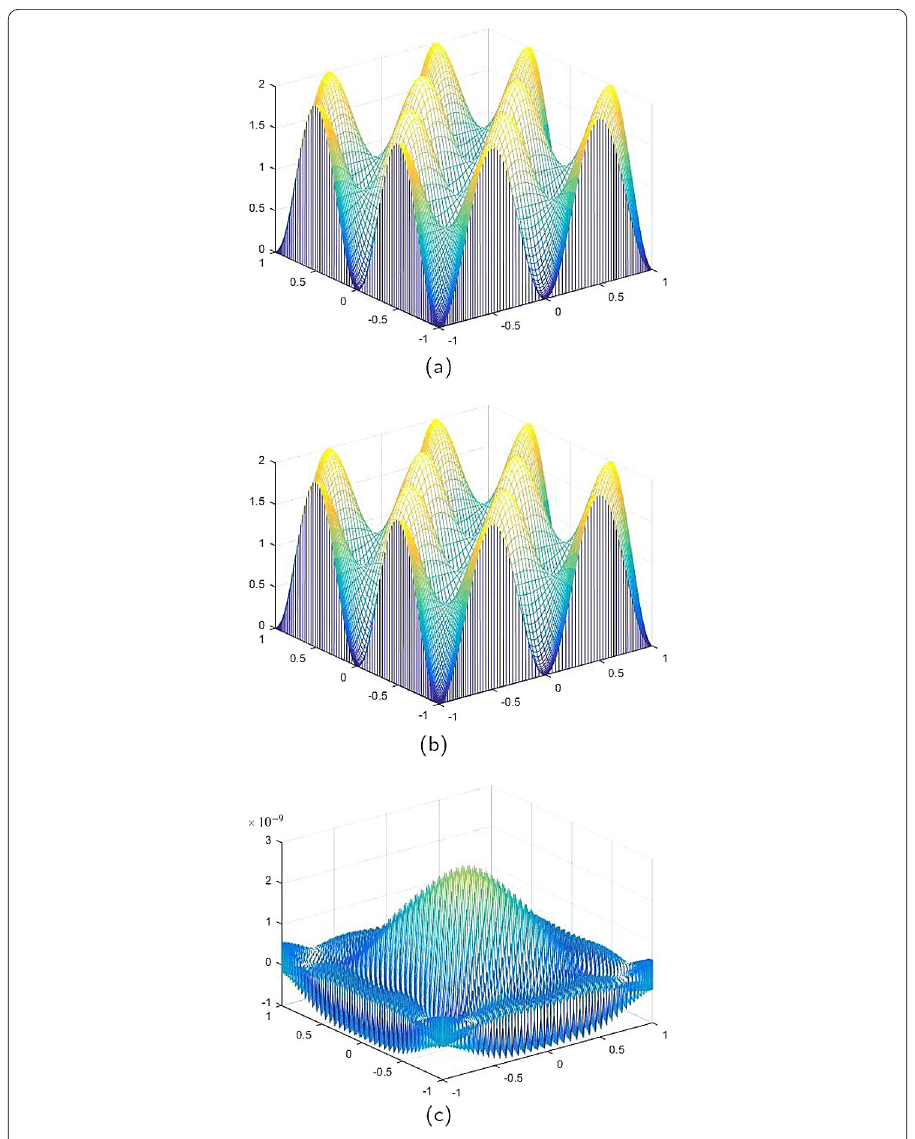
Figure 1 (a) The CNCS solution when t = 0.0. (b) The analytical solution when t = 0.0. (c) The errors between the analytical solution and CNCS solution at t =